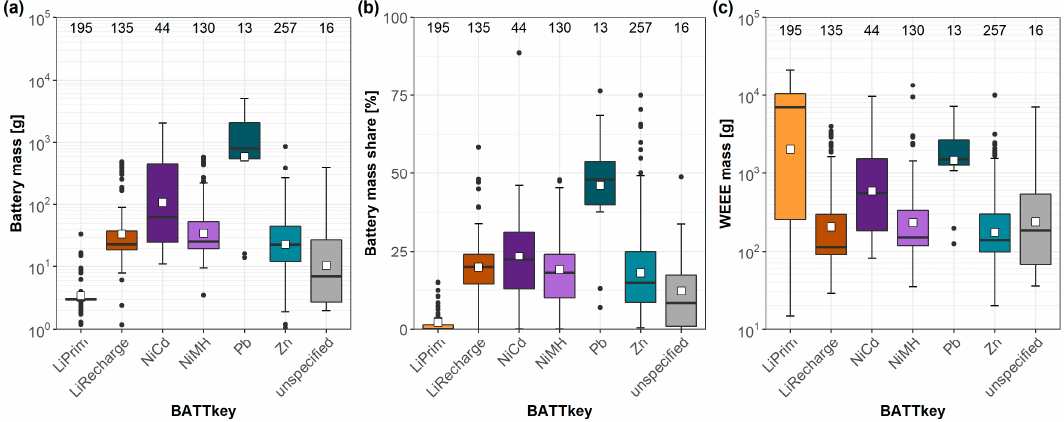
Figure 3. Battery mass ( a ), battery mass share ( b ), and WEEE mass ( c ) differentiated according to their chemical systems (BATTkey). The mass is illustrated with a logarithmic scale. The lower and upper hinges of the boxplots correspond to the first and third quartiles (the 25th and 75th percentiles). The median is drawn as a bold horizontal line; the mean is shown as a square. Upper/lower whisker is the largest/smallest observation less/greater than or equal to upper/lower hinge +/ − 1.5 ∗ interquartile range (IQR). The black dots represent values that lie outside of this range.